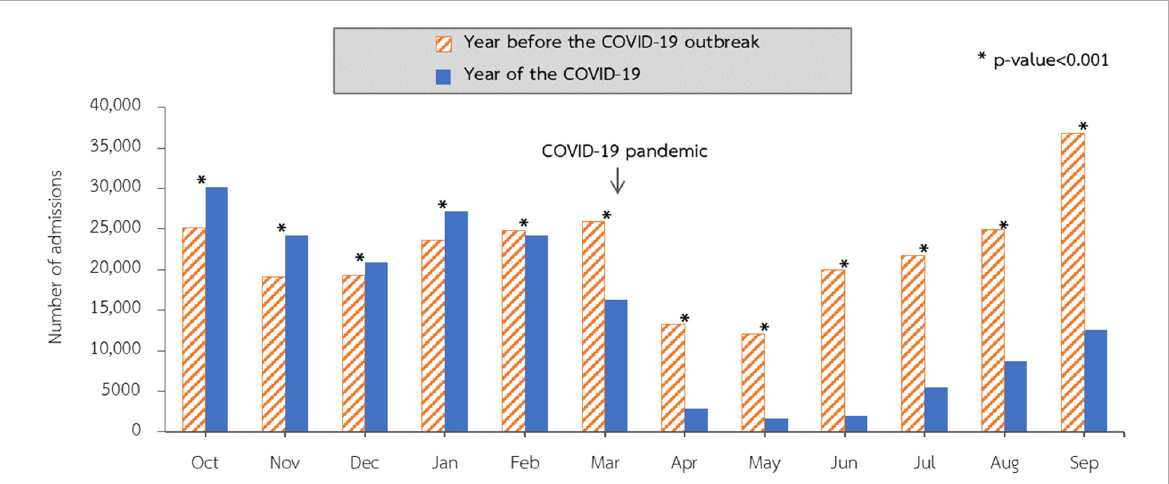
Figure 1. Number of hospitalized LRTIs in fiscal years 2015–2020.